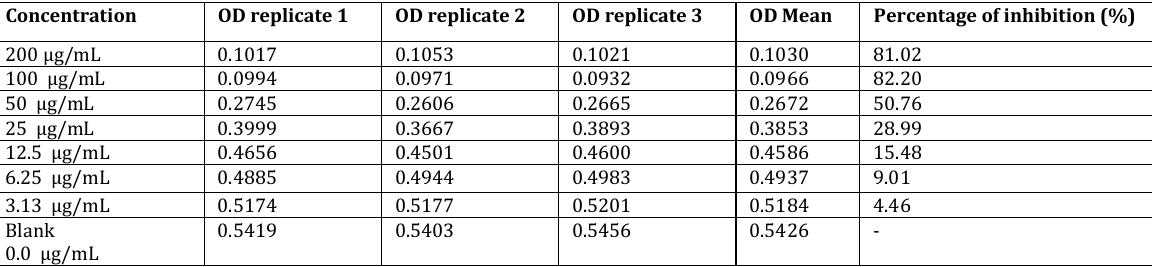
Table 2: Percentage of oxidation inhibition of middle-age leaves